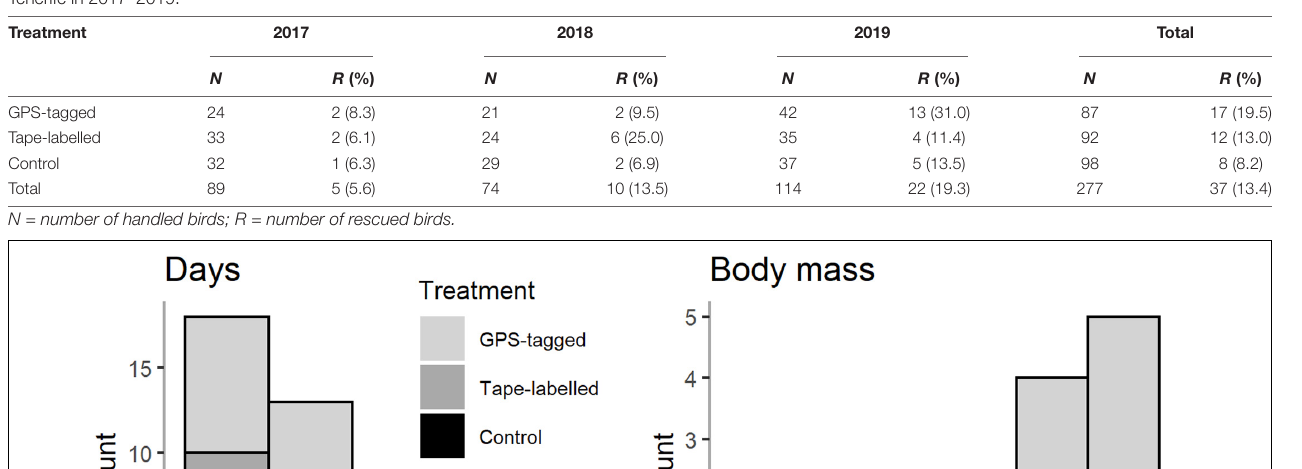
TABLE 2 | Number of Cory’s Shearwater ( Calonectris borealis ) fledglings experimentally released, and those recovered during rescue campaigns (R) in Tenerife in 2017–2019.